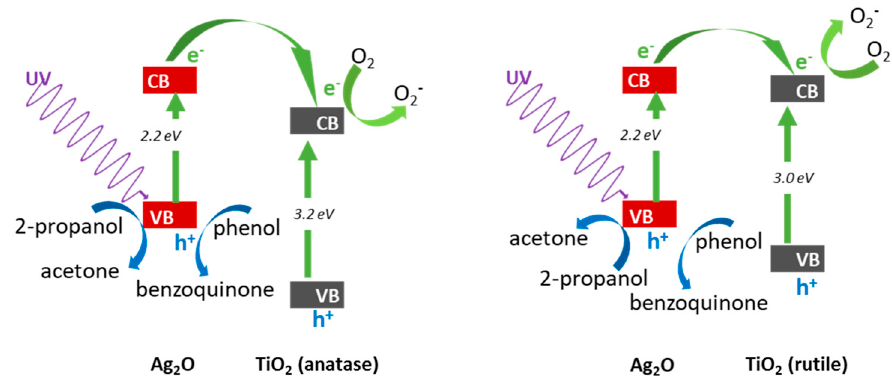
Figure 11. The schematic mechanisms of oxidative decomposition of 2-propanol and phenol under vis irradiation with Ag 2 O/TiO 2 photocatalysts for anatase ( a ) and rutile ( b ).